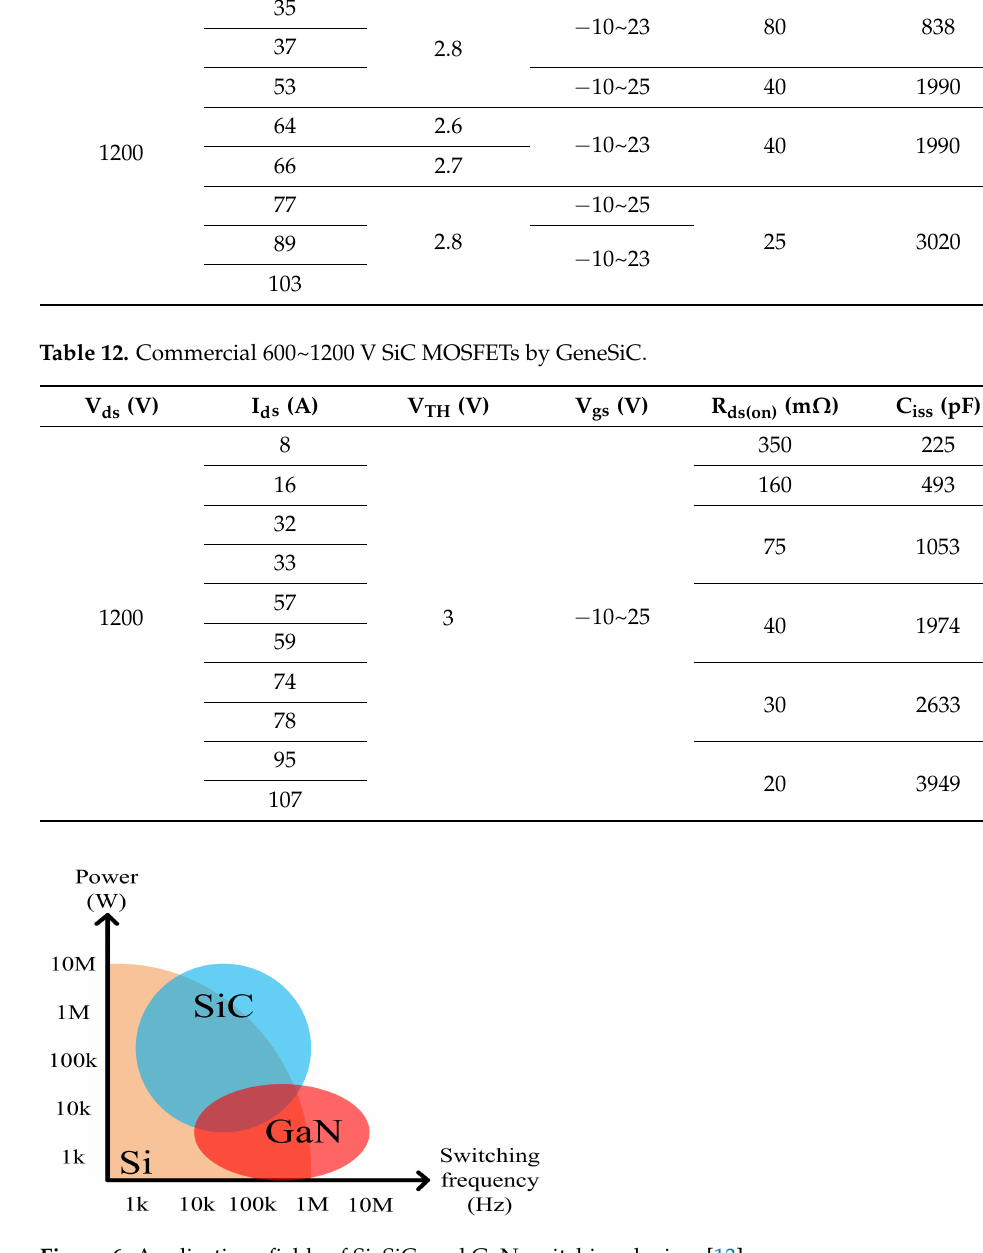
Figure 6. Applications fields of Si, SiC, and GaN switching devices